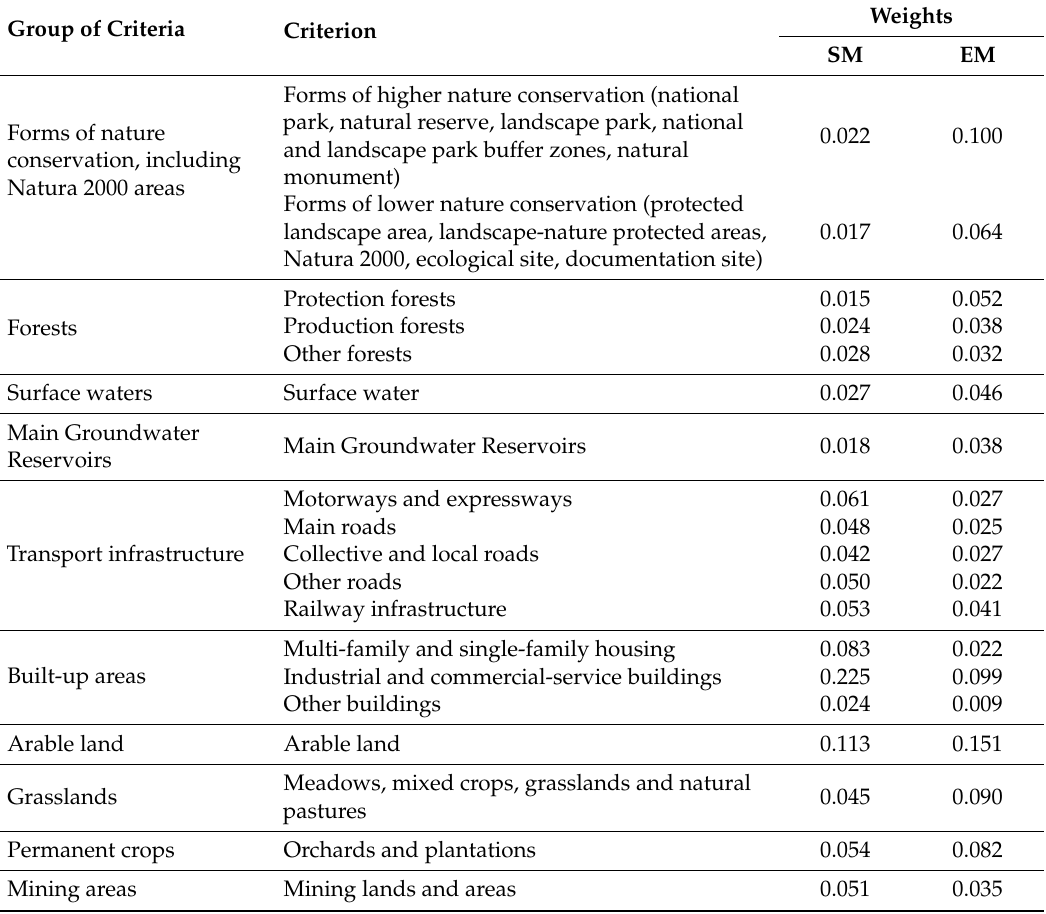
Table 2. The accessibility criteria for dimension and crushed stone deposits for the social and environmental